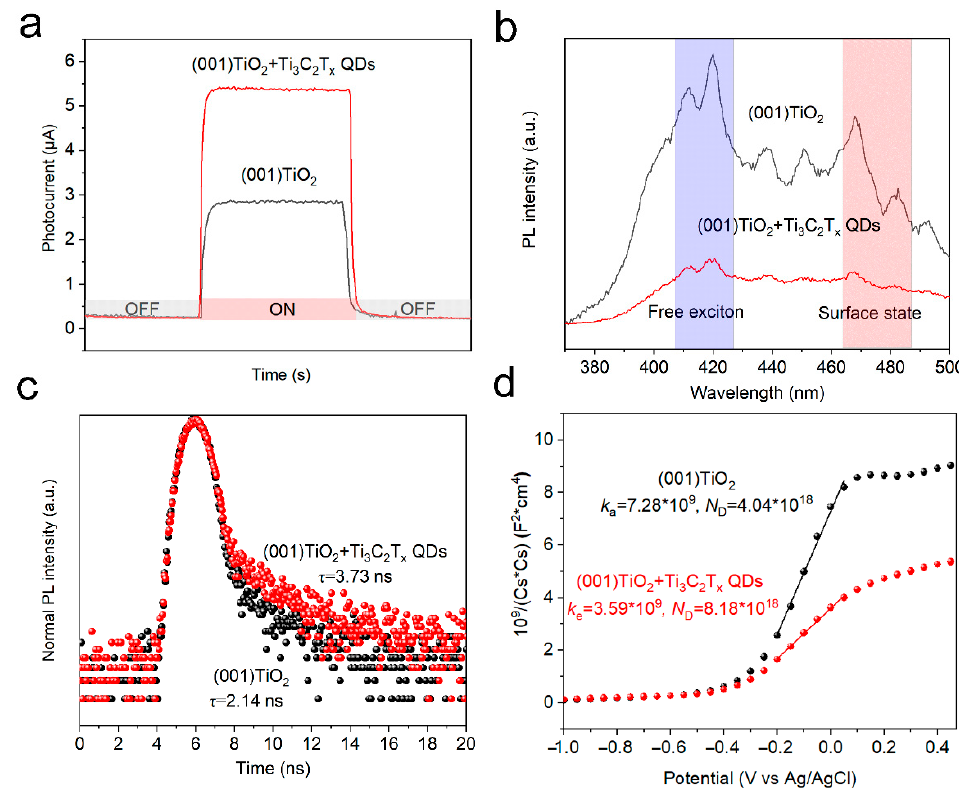
Figure 4. ( a ) Time-resolved current response curves, ( b ) Photoluminescence (PL) spectroscopy, ( c ) Time-resolved photoluminescence (TRPL) emission spectroscopy spectra, and ( d ) Mott–Schottky plot of pristine (001) TiO 2 and Ti 3 C 2 T x QDs/(001) TiO 2